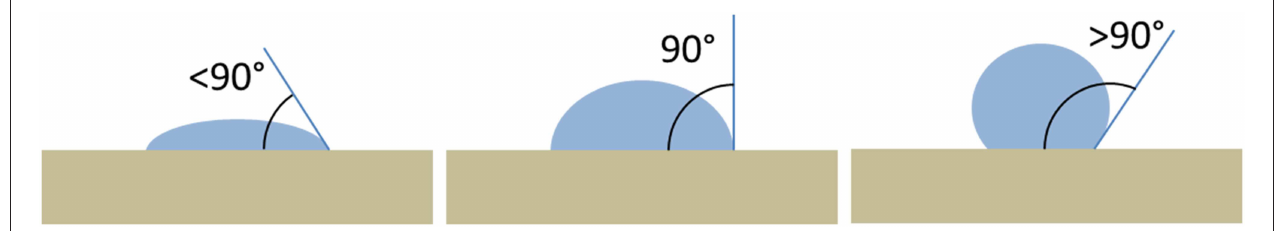
FIGURE 1 | Schematic representation of contact